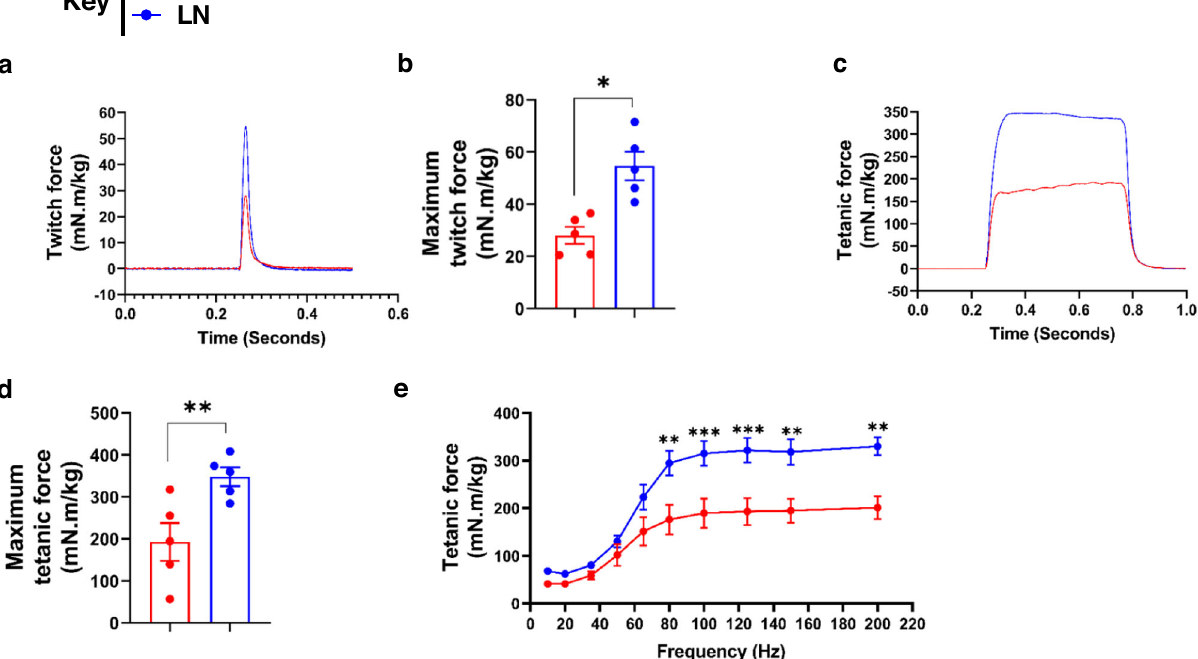
Fig. 8 | NANOG restores contraction force generation by LAKI mouse muscle in vivo.a , b Effectof NANOG on twitchforce contraction. c , e Effect of NANOGon tetanicforce contractionpro fi le c , maximum tetanicforce d , and tetanic force asa function of stimulationfrequency e by LAKIdorsi fl exor musclesinvivo.L:red bars